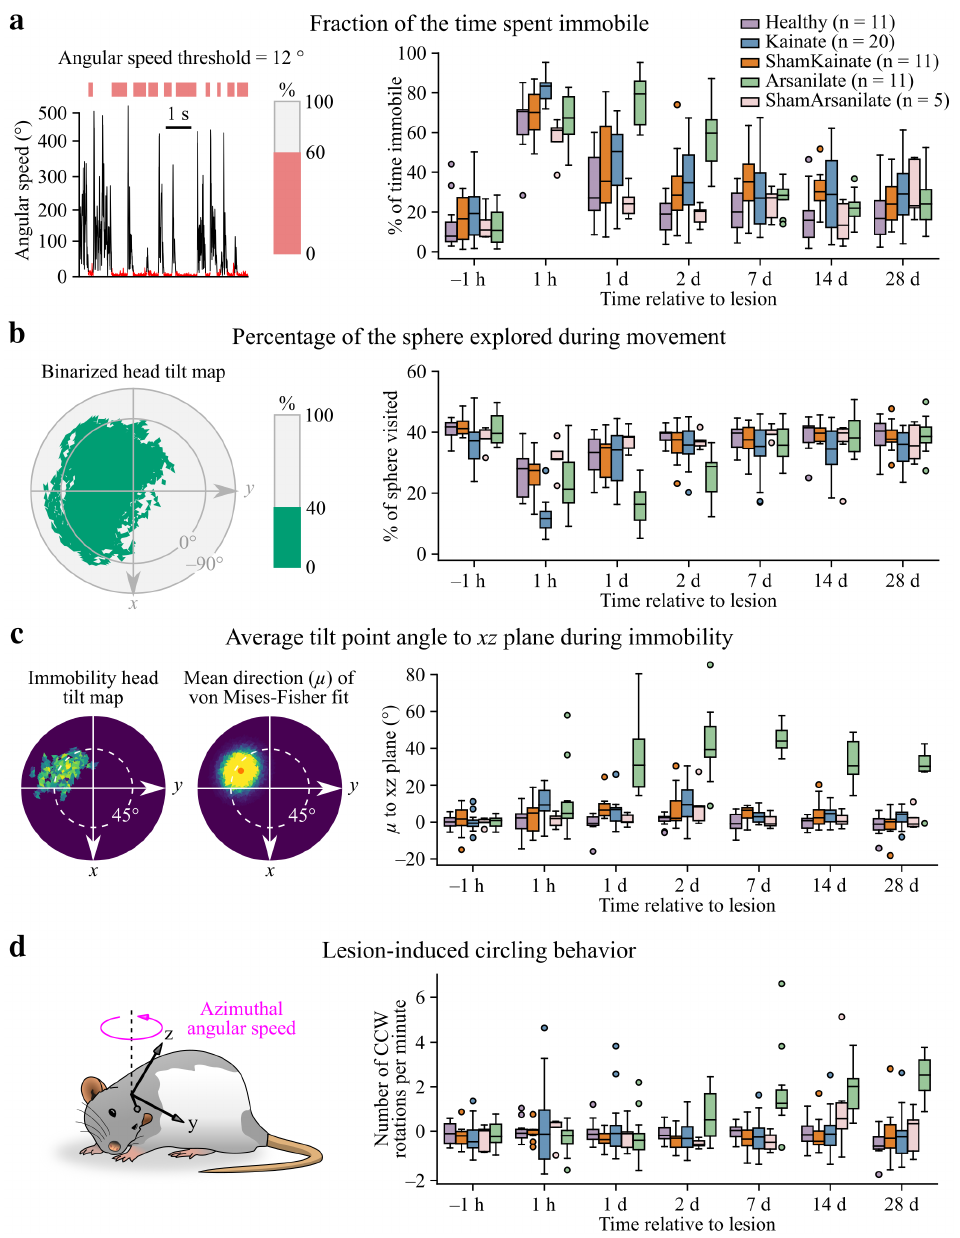
Figure 4. IMU-extracted features describing lesion-induced deficits and their temporal dynamics. ( a ) Fraction of the time spend immobile, calculated by angular speed thresholding (left) and plotted for all groups and all time points (right). ( b ) Fraction of the unit sphere visited during movement by the gravitational acceleration vector (Madgwick estimate) in the head reference frame plotted for all groups and all time points. ( c ) Angular distance to the sagittal ( xz ) plane of the mean direction of a von Mises–Fisher distribution (orange dot on the left) fitted on each head tilt map during immobility, plotted for all groups and all time points (right). ( d ) Estimate of the average number of counter-clockwise rotations per minute plotted for all groups and all time points (right), and computed by integrating the azimuthal angular speed (i.e., the angular speed about the axis defined by the gravitational acceleration vector). This figure uses Tukey boxplots, where the horizontal line is the median, boxes are the interquartile range (IQR), whiskers extend to the most extreme points within the median ± 1.5 IQR interval and outliers are points beyond this